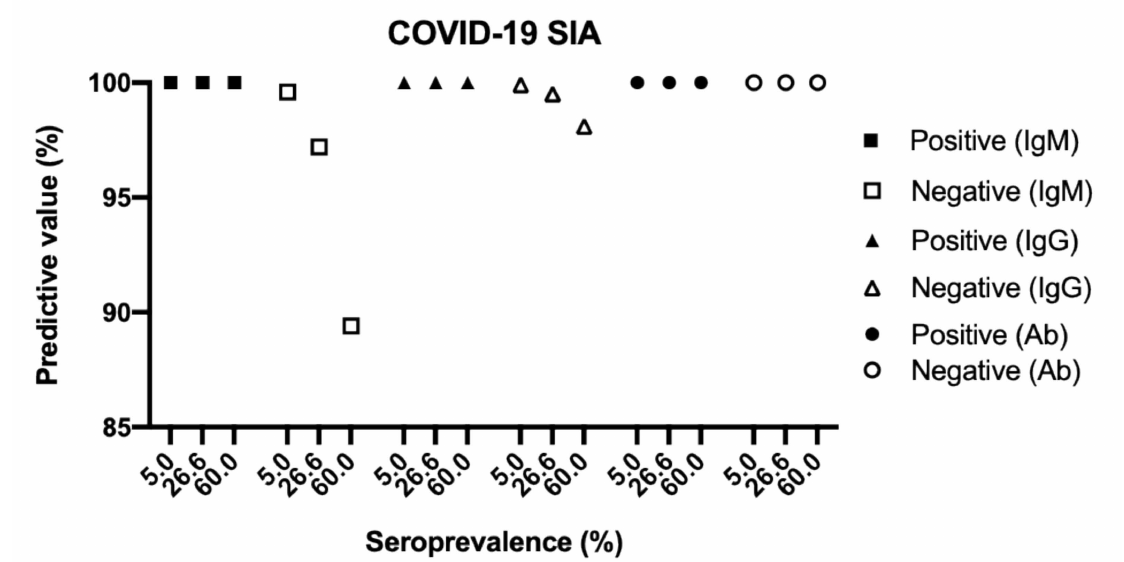
Figure 2. Predictive values of the COVID-19 SIA at three different seroprevalences. The predictive values were plotted as a function of seroprevalence using the values for sensitivity and specificity in Table 4 and the following formulas: Positive predictive value = (seroprevalence * sensitivity) / ((seroprevalence * sensitivity) + ((1 − seroprevalence) * (1 − specificity))); Negative predictive value = ((1 − seroprevalence) * specificity) / ((seroprevalence * (1 – sensitivity)) + ((1 – seroprevalence) * specificity)). COVID-19, Coronavirus disease 2019; SIA, suspension immunoassay; Ig, immunoglobulin, Ab, IgM + IgG.